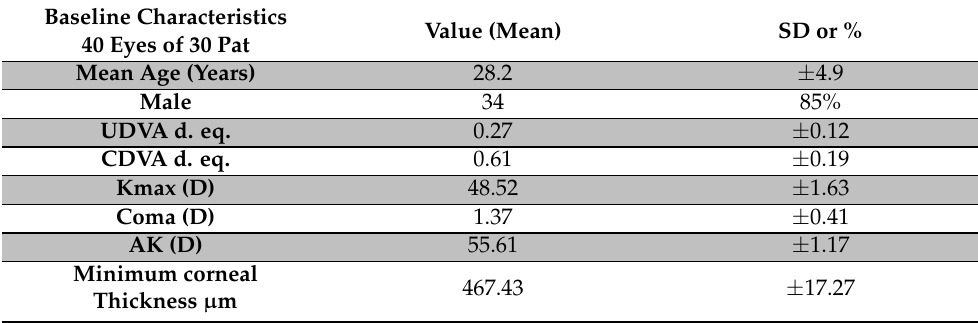
Table 2. The baseline demographic